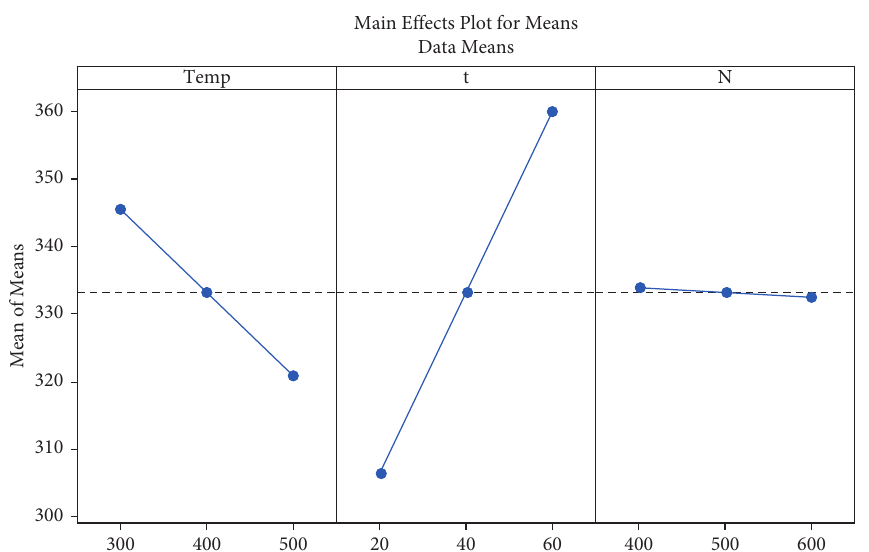
Figure 7: Significant consequence diagram based on means for compressive strength (temp: temperature in ° C; t : time in sec; N : stir speed in